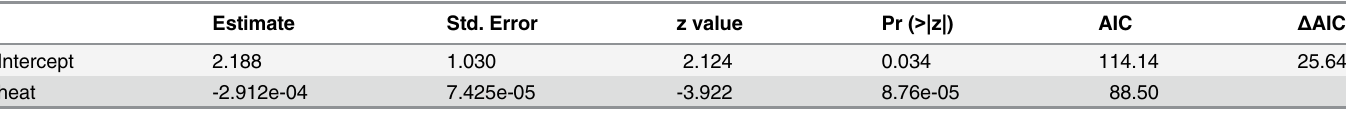
Table 4. Output summary of the logistic regression model of survival of E . atala pupae as a function of heat following prescribed burning July 5 th - 6th, 2012, at the Ordway Swisher Biological Station, Melrose, Florida.